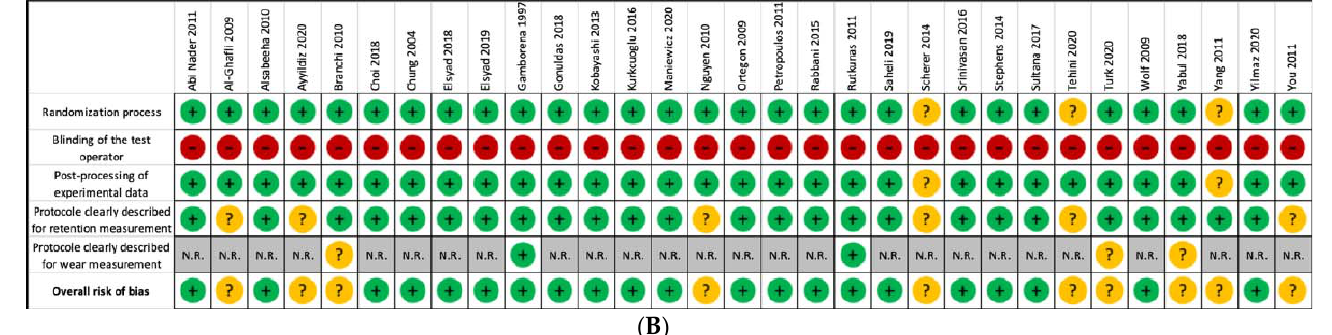
Figure 4. Risk of bias summary: authors’ assessment of each risk of bias item for each included clinical ( A ) and in vitro study ( B ).